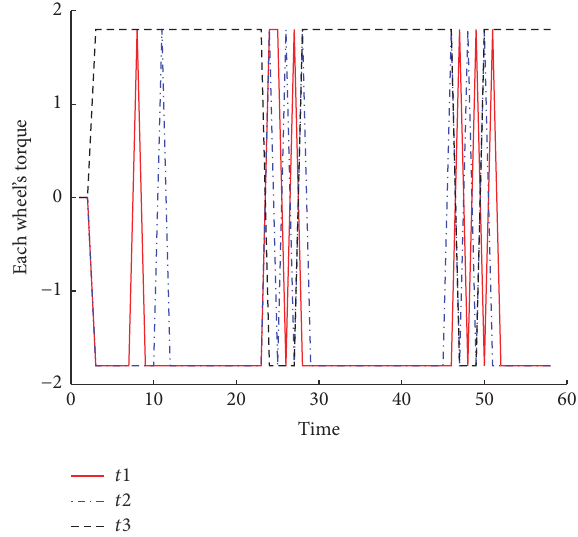
Figure 16: The change of torque of the